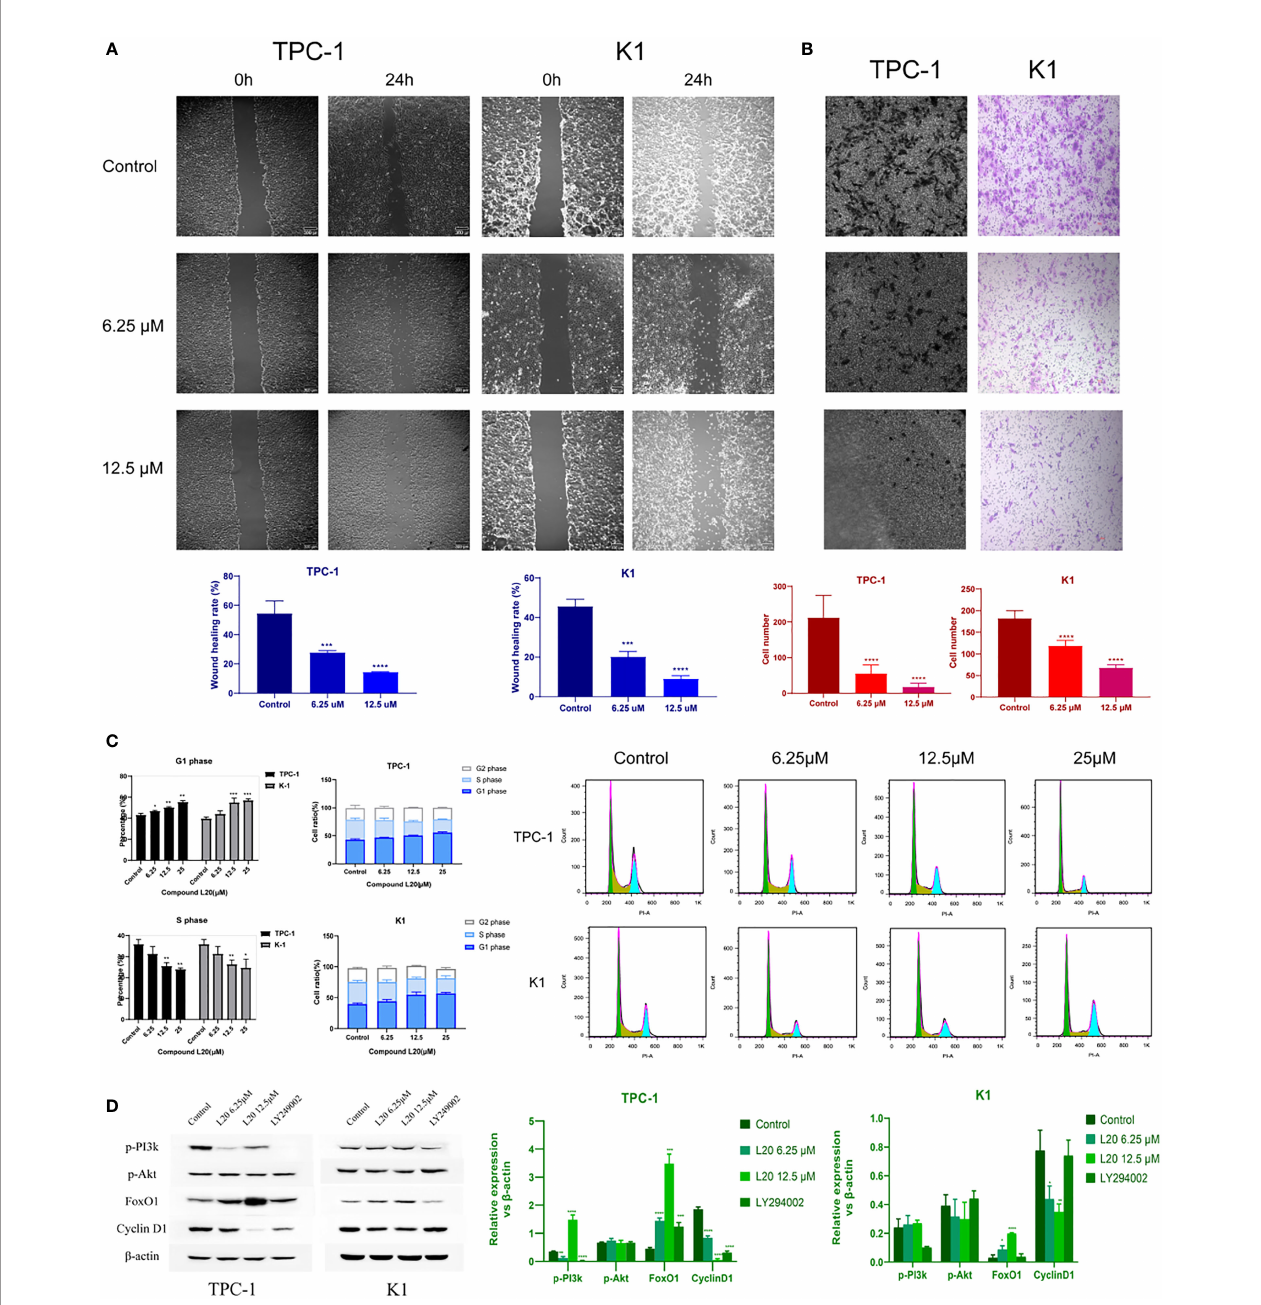
FIGURE 4 | Mito-Fu L20 attenuated PTC migration and invasion, delayed the tumor cell cycle, and inhibited the PI3K/Akt pathway. (A) Wound healing assays were performed to examine cell migration capacity (scale bar: 300 m m). (B) Invasive capacities of PTC cells were measured by Transwell assays (scale bar: 300 m m). (C) Flow cytometry and (D) Western blotting analysis were used to detect changes in the expression patterns of proteins involved in the PI3K/Akt/FoxO/Cyclin D1 pathway and changes in the cell cycle in treated normal thyroid follicles and PTC cells. *P < 0.05, **P < 0.01, ***P < 0.001, ****P < 0.0001. Values are means of three replicates, and all experiments were performed at least three